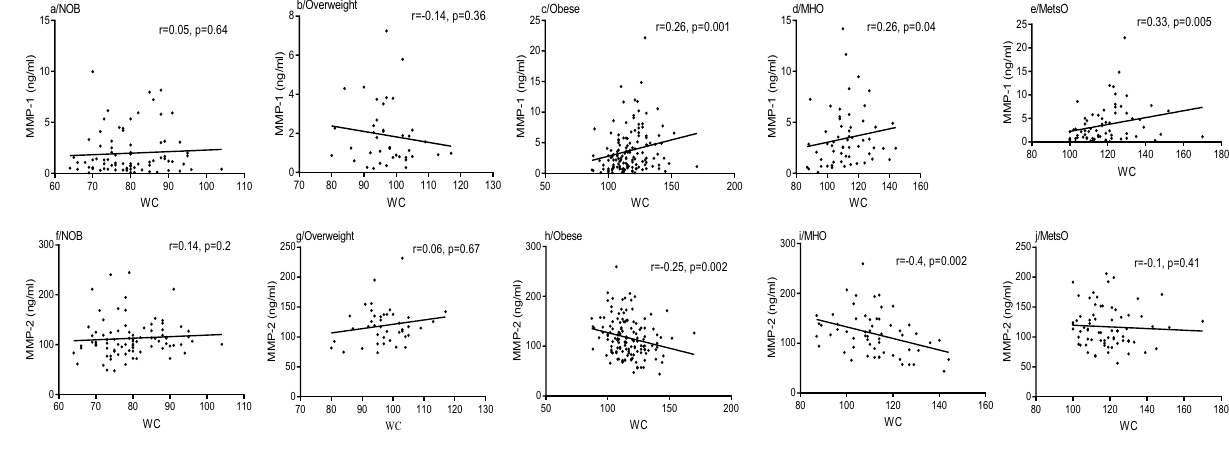
Figure 2. Spearman Rank correlation between WC and MMP-1 and MMP-2 plasma levels respectively, according to obesity status. Regression coefficient (r) and statistical significance (p) are reported for each test. p-value < 0.05 is significant. NOB non-obese, MHO metabolic healthy obese, MetsO metabolic syndrome obese, WC waist circumference.